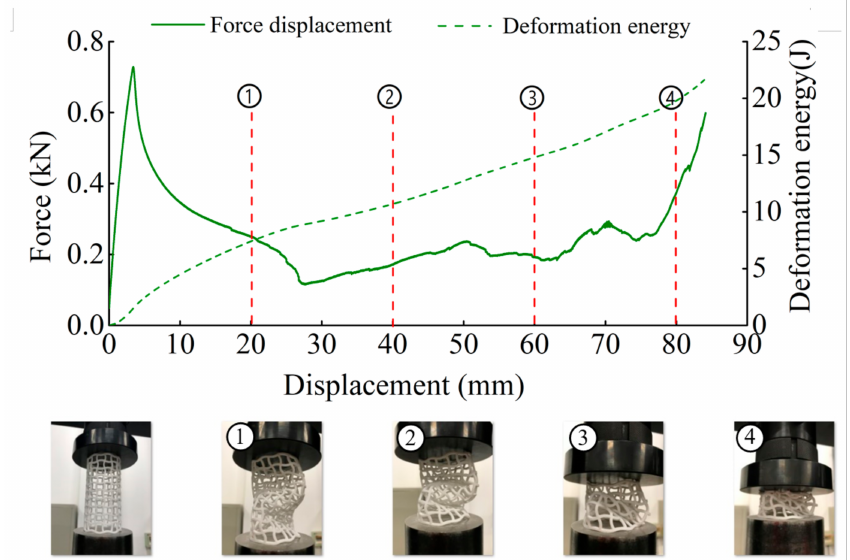
Figure 7. Deformation process of CCHT1 (1–4 stages of deformation during quasi-static compression